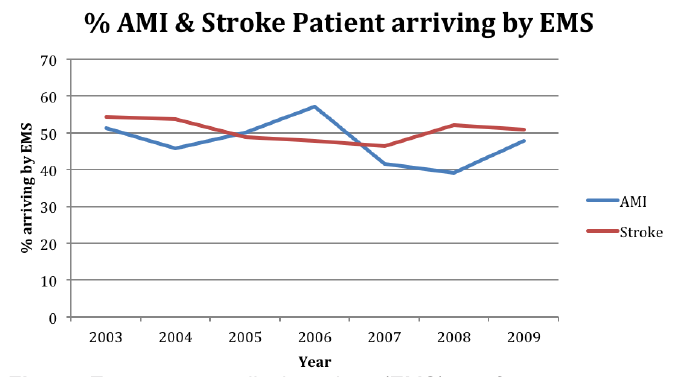
Figure. Emergency medical services (EMS) use for acute myocardial infarction (AMI) and stroke between